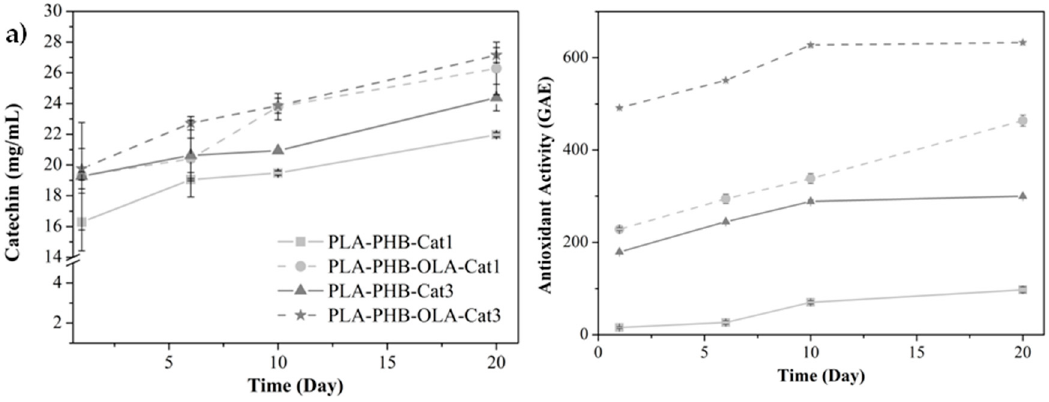
Figure 5. ( a ) Catechin release from bilayer materials to the food simulant and ( b ) antioxidant activity expressed as gallic acid concentration measured by DPPH radical scavengers.